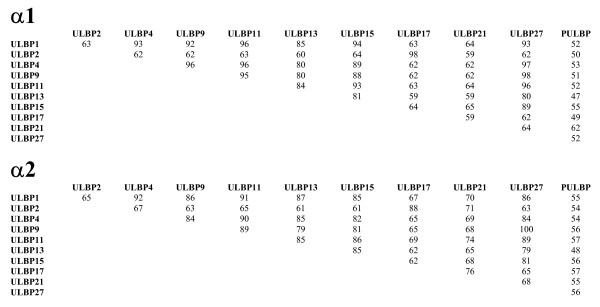
Sequence identity in the extracellular domains ofcattle and swine ULBPs. Percent pair-wise sequence identity between the α1 and α2 domains of ten cattle ULBP proteins and porcine ULBP [GenBank: AAP81932]. Sequence alignments were made using BLASTP and edited manually.